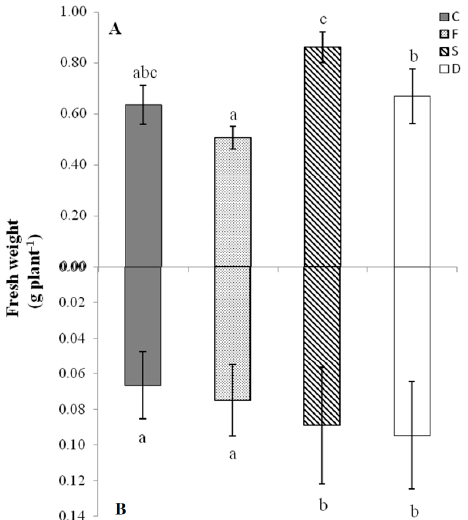
Figure 1. Biomass accumulation of tomato plants . Shoot ( A ) and root ( B ) fresh weight (g plant − 1 ) of tomato plants subjected to different nutritional treatments (C = control, F = Fe deficiency, S = S deficiency, D = dual deficiency). Data are means ± SD of six independent replicates run in triplicate. The statistical significance has been tested by a one-way ANOVA test with Tukey post-test. Significant differences between samples are indicated by different letters ( p < 0.01).